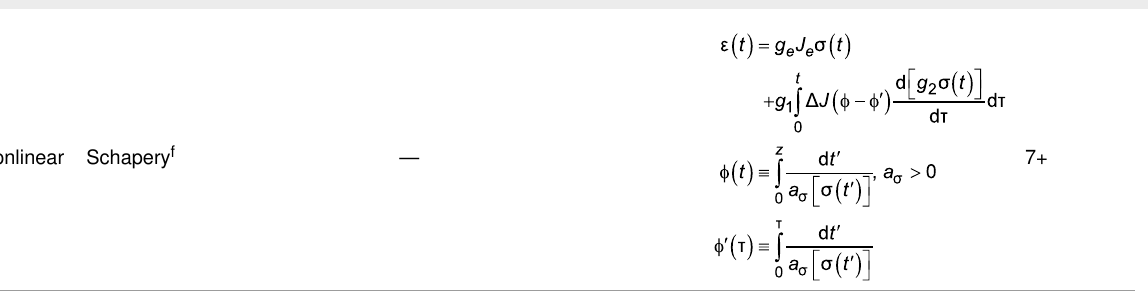
Table 1: Summary of viscoelastic models and the corresponding applications [14,15,22]. (continued)